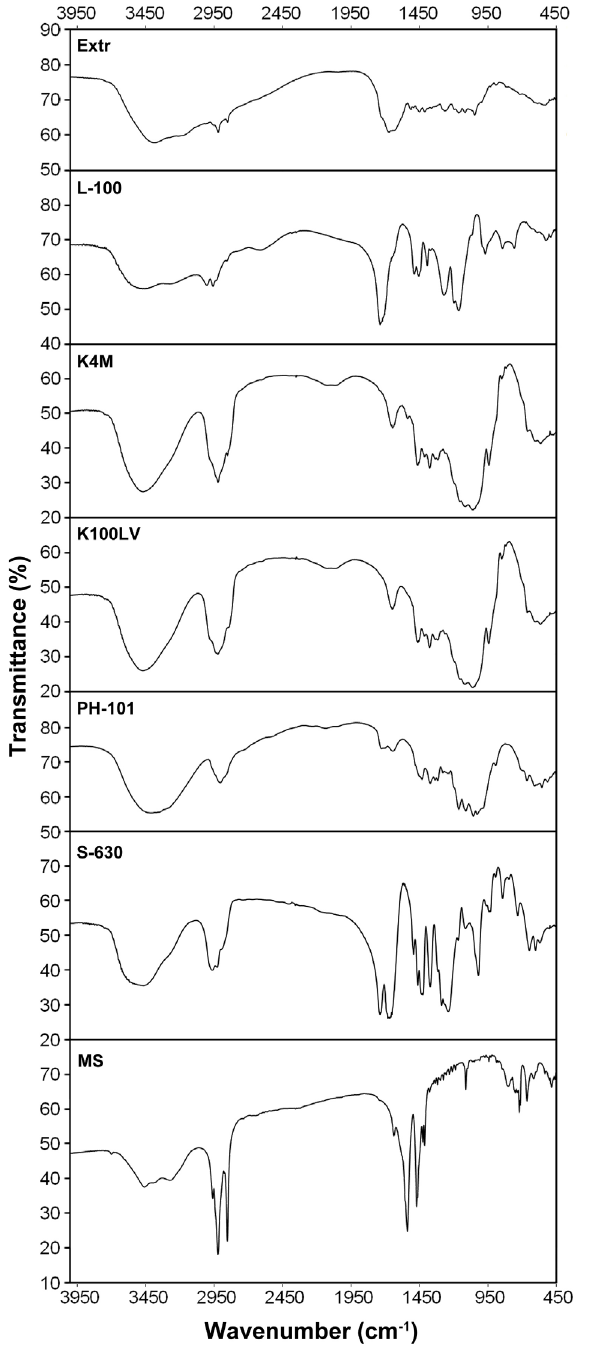
FIGURE 4 – FTIR spectra of the individual samples: bilberry leaf powder extract (Extr), Eudragit L100 (L-100), Methocel K4M (K4M), Methocel K100LV (K100LV), Avicel PH-101 (PH-101), Plasdone S-630 (S-630), and magnesium stearate